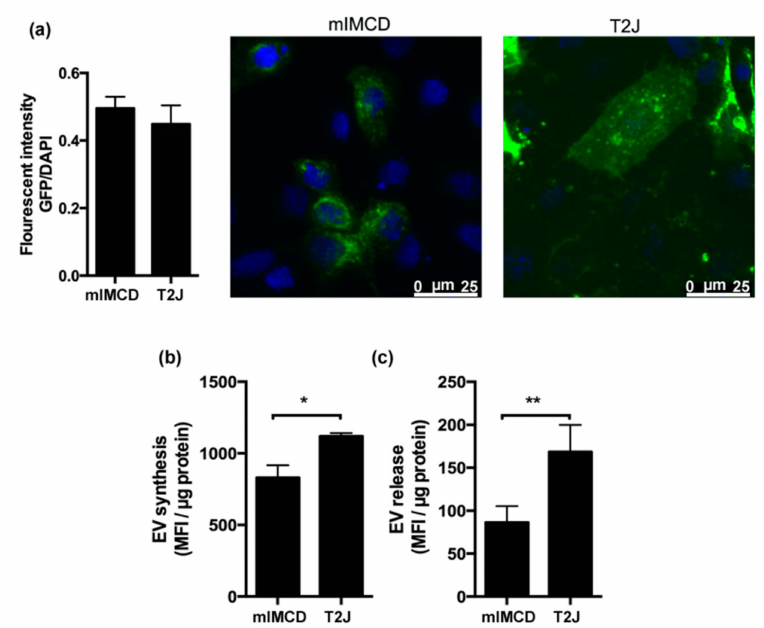
Figure 3. Extracellular vesicles synthesis, release and uptake. mIMCD and T2J cells were transfected withgreenfluorescentprotein(GFP)taggedCD63, markerofextracellularvesicles(EVs). ( a )Transfection e ffi ciency was tested in 96-well culture plate by measuring mean fluorescent intensity of GFP normalized to intensity of nuclear 4 (cid:48) ,6-diamidino-2-phenylindole (DAPI) stain ( n = 3). Example of merged GFP and DAPI slide shown on right. ( b ) Synthesis of EVs from mIMCD and T2J cells measured 48 h after 0.2 µ g GFP-CD63 transfection in a 12-well cell culture plate. After multiple washes, cells were lysed in lysis bu ff er and split for measurement of GFP fluorescent intensity and protein content ( n = 3). ( c ) EV release mIMCD and T2J cells measured from debris-free cell media. GFP-fluorescence was normalized to protein content in cell media ( n =